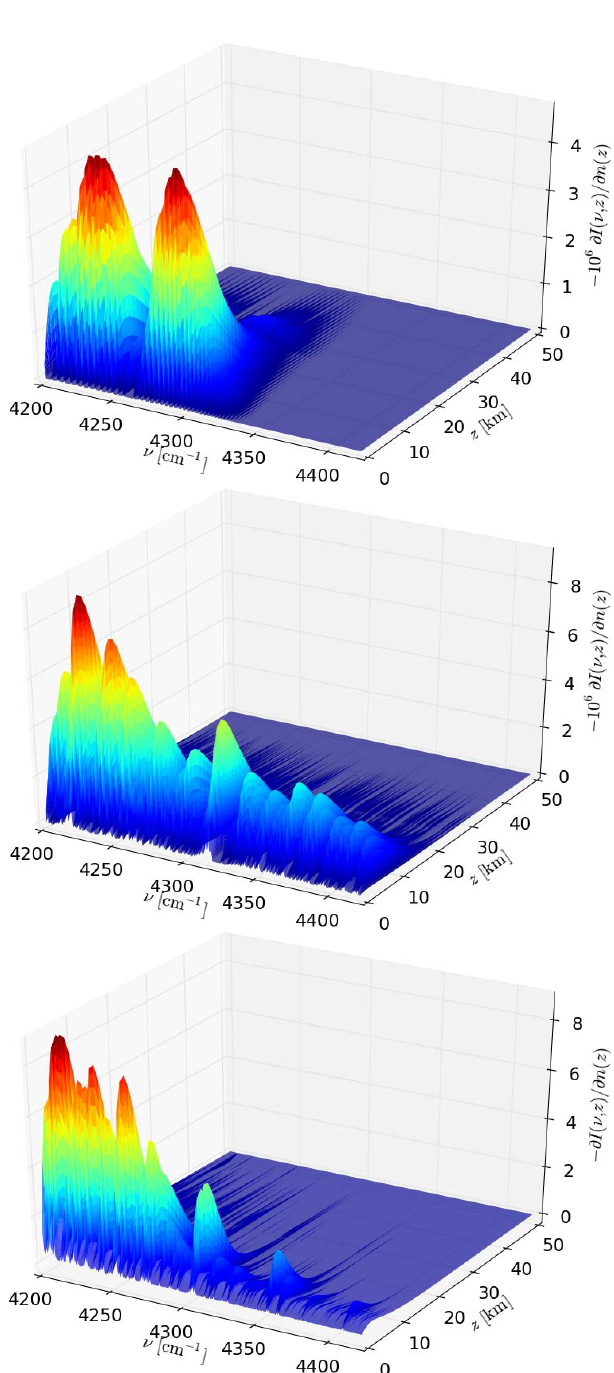
Fig. 1. Jacobians [ erg / s /( cm 2 srcm − 1 )/ ppm ] for molecular con- centration profile retrieval in channel 8: CO (top), CH 4 (mid), and H 2 O (bottom). Note the scaling by 10 6 of the CO and CH 4 Jaco- bians. The derivatives were calculated using GARLIC for a US standard atmosphere up to 50km, a Gaussian slit function with γ = 0 . 2cm − 1 , and vertical downlooking observer at